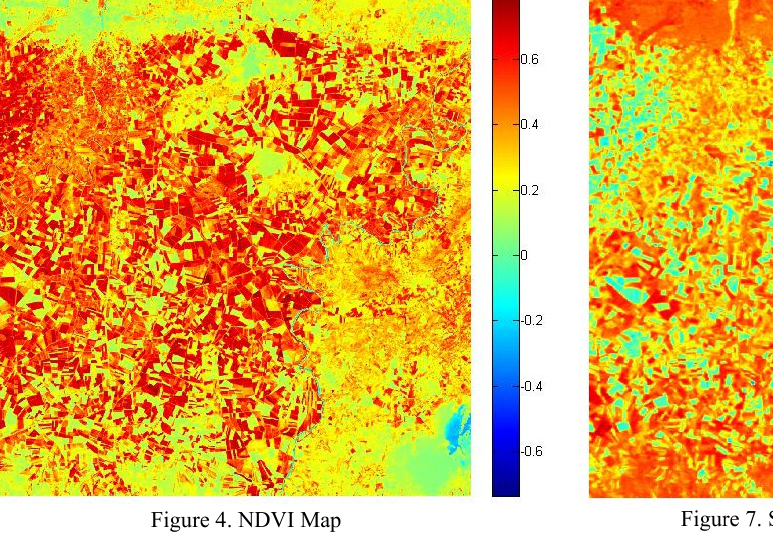
Figure 4. NDVI Map